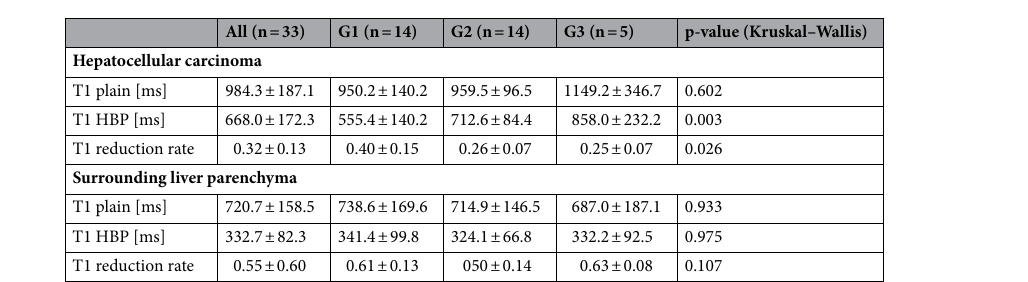
Figure 3. Boxplot of the T1 time and tumor reduction rate in the hepatobiliary phase. ( a ) Mean T1 time of HCC on plain and postcontrast images (HBP, hepatobiliary phase) with the relevant p-values for the comparison of Gd-EOB-DTPA uptake. ( b ) Tumor reduction rate between the plain and hepatobiliary phases for well- (G1), moderate (G2) and poorly (G3) differentiated HCCs. Data presented as box plots follow standard Tukey representations. The Wilcoxon signed rank test (#) and the post-hoc pairwise comparisons of the Kruskal– Wallis test (+) were used to compare groups.